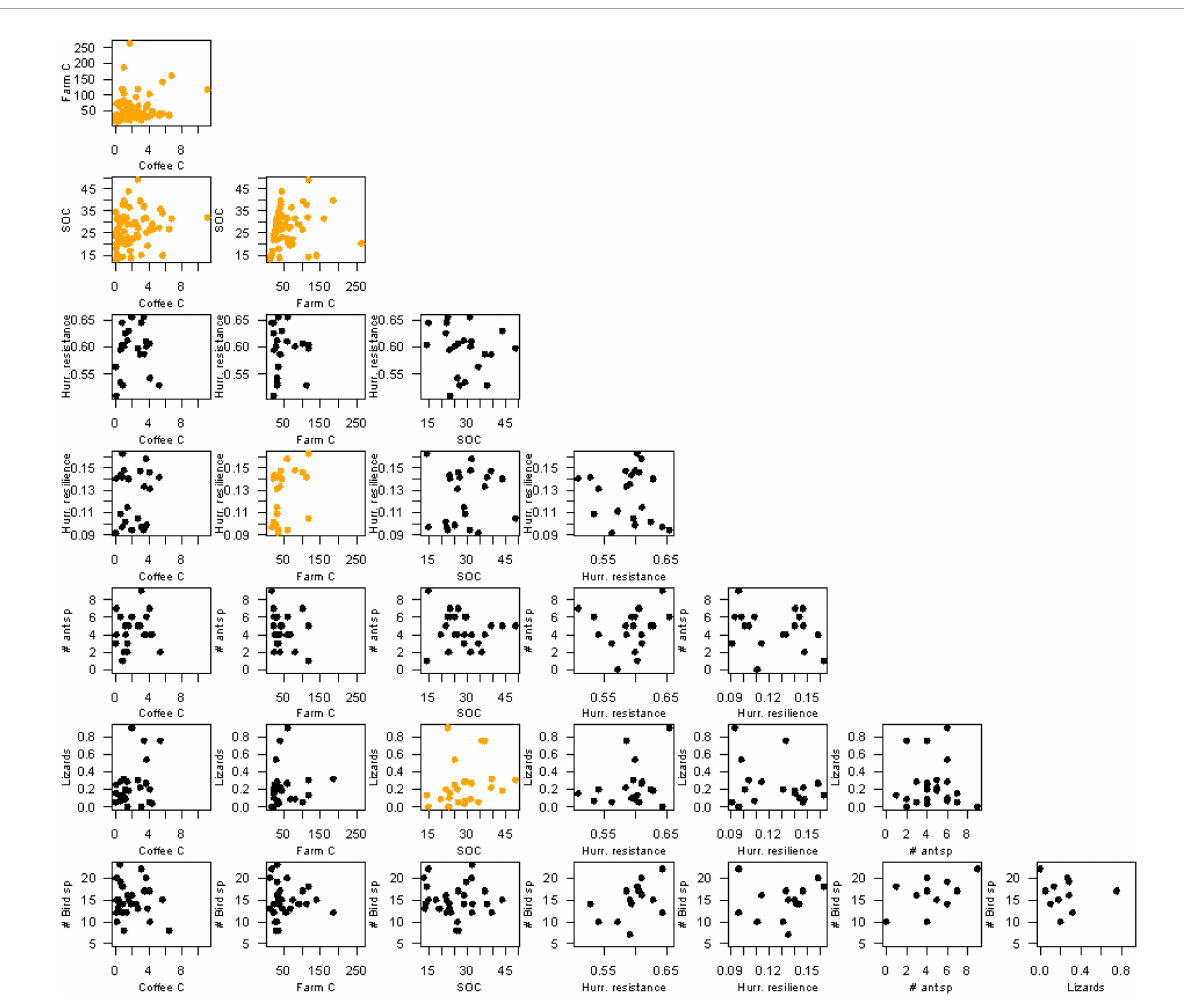
FIGURE7 Scatter plots for all of the ecosystem service and biodiversity conservation variables in the coffee system studied. Black data points indicate non-significant relationships and yellow data points indicate a positive significant relationship ( p <